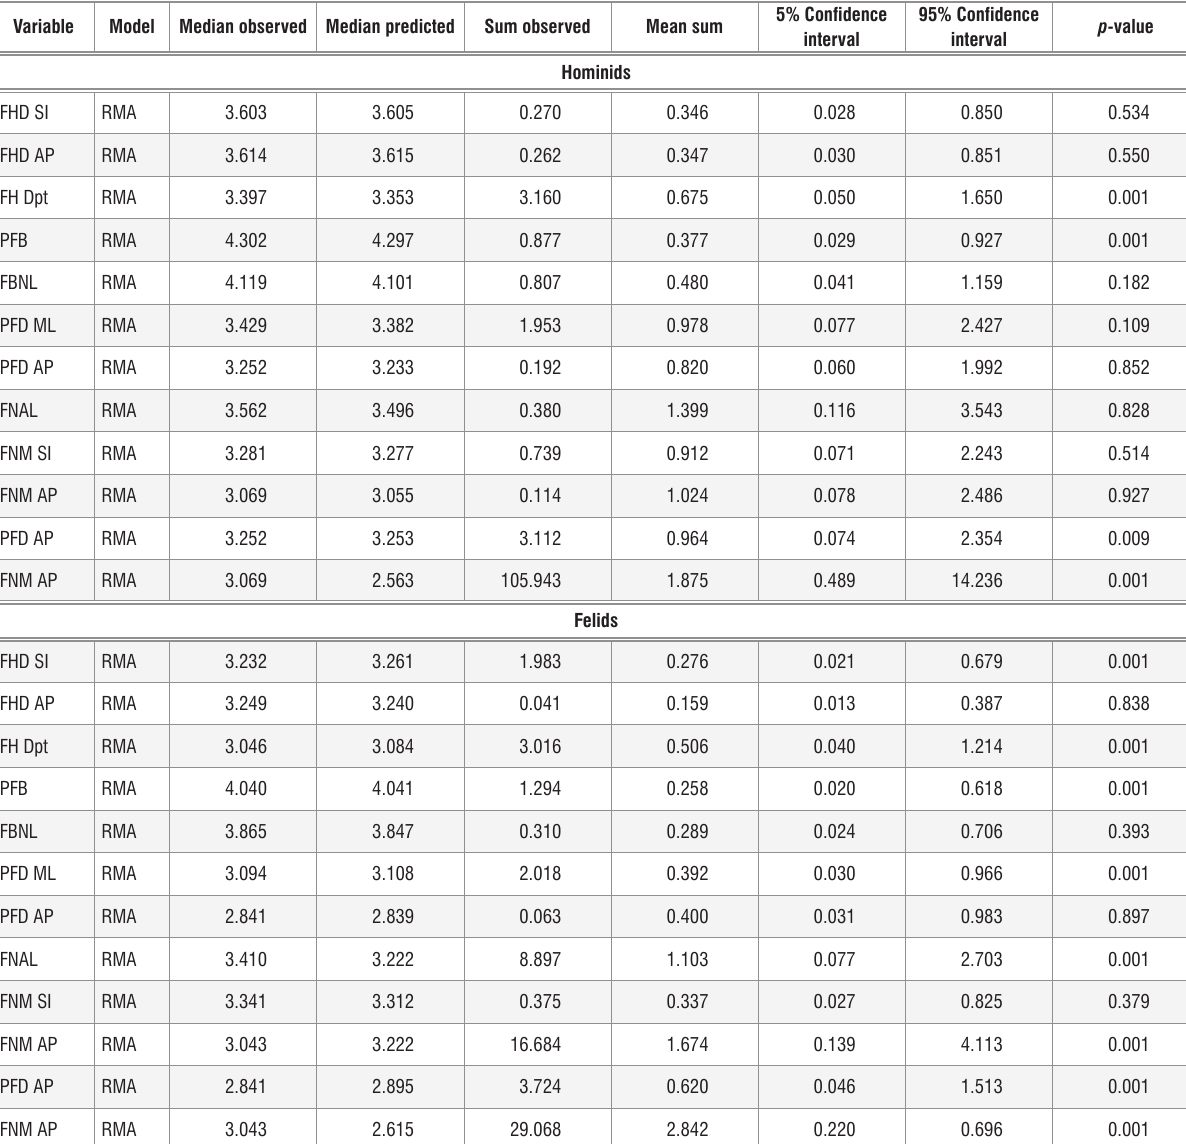
Table 6: Fisher’s paired randomisation comparisons Variable Model Median observed Median